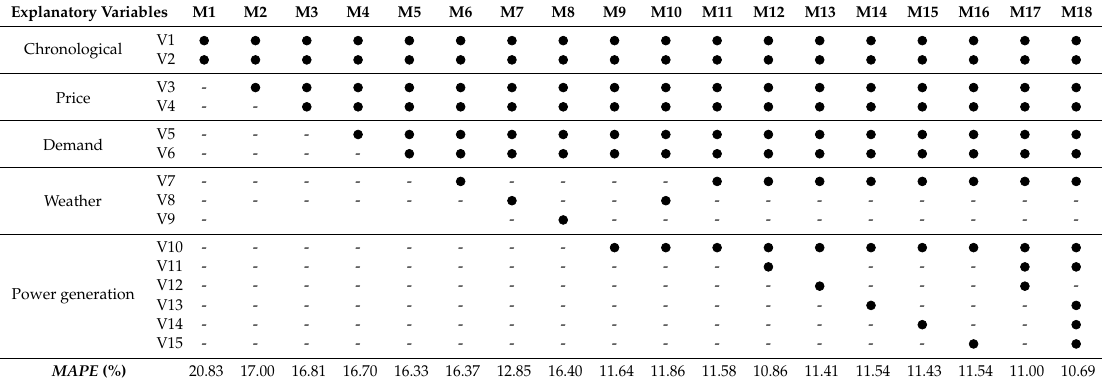
Table 6. DSMPF models and their MAPEs .